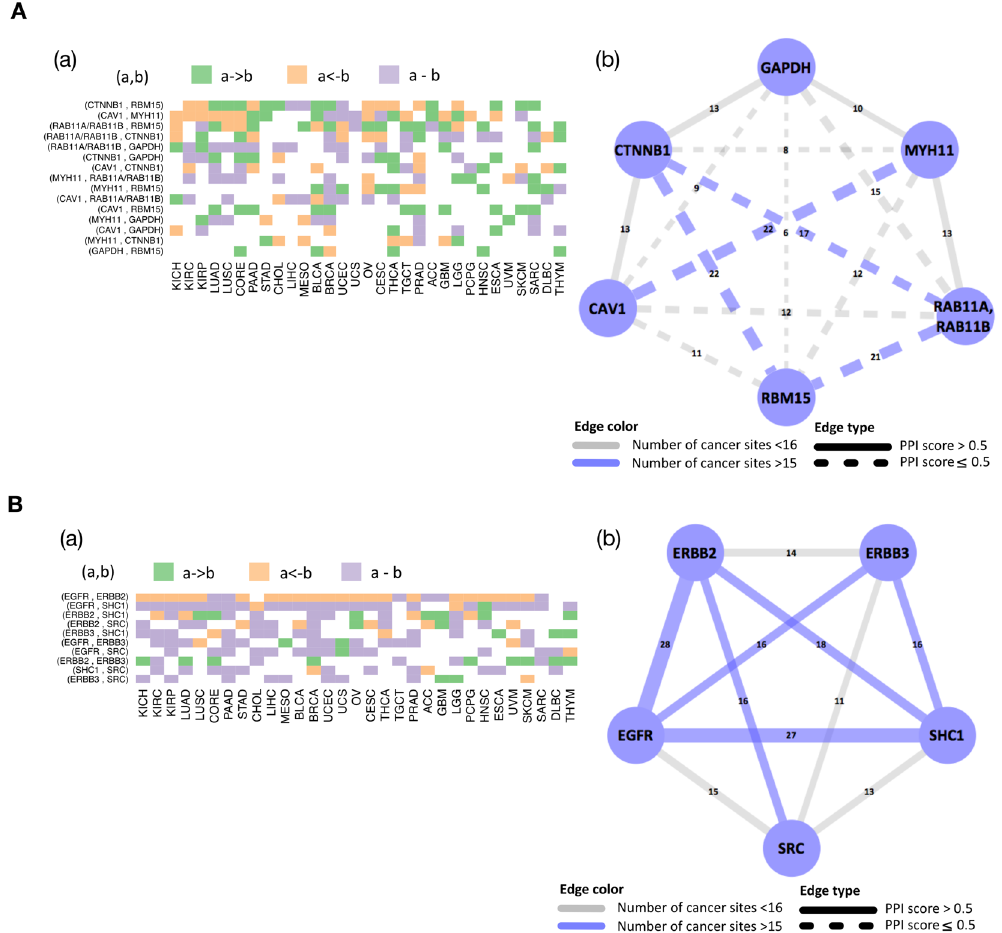
Figure 2. Cancer-specific protein networks for breast reactive ( A ) and RTK ( B ) pathways. (a) Heatmap depicting regulatory ( −> or <− ) and correlative ( − ) edges across all tumor lineages. (b) Network, where each of the edges is weighted and labeled by edge consistency (EC), defined as the number of tumor types that hold the particular